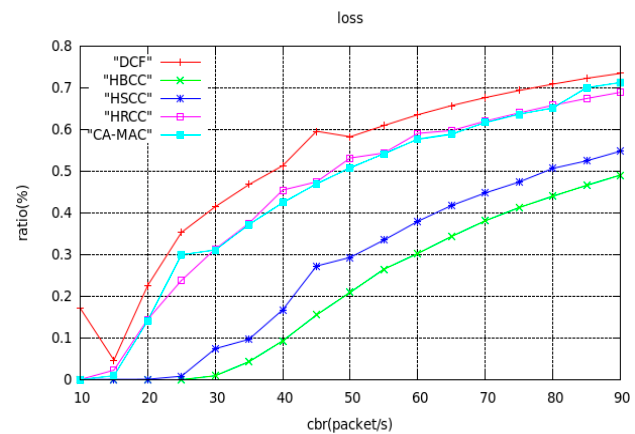
Figure 8. Curves of buffer overflow loss ratio with network load.